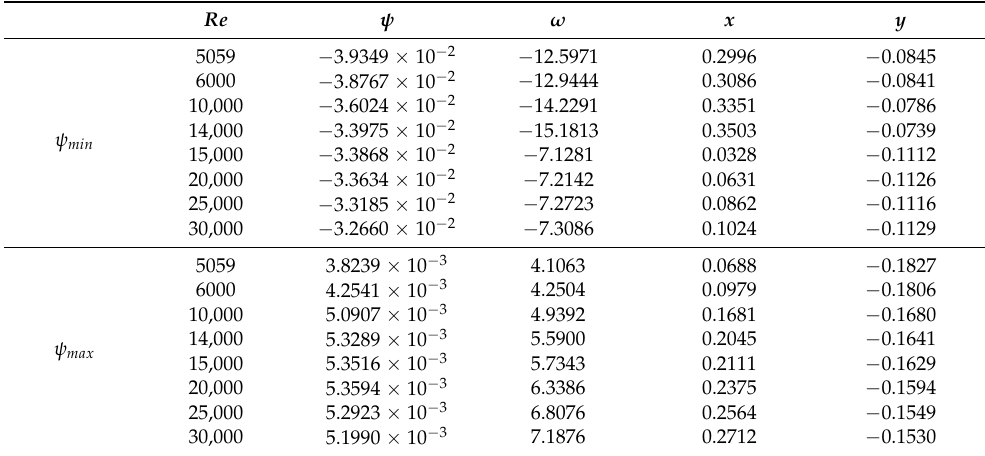
Table 4. Minimum and maximum streamfunction values in the 2nd solution, corresponding vorticity values and ( x , y ) locations for D = 0.5 aspect